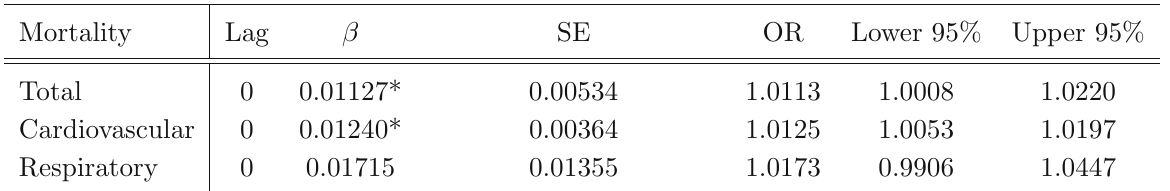
Table 3 ORs (95% CIs)/10 µ g/m 3 increase in concentration of BS for daily numbers of deaths.